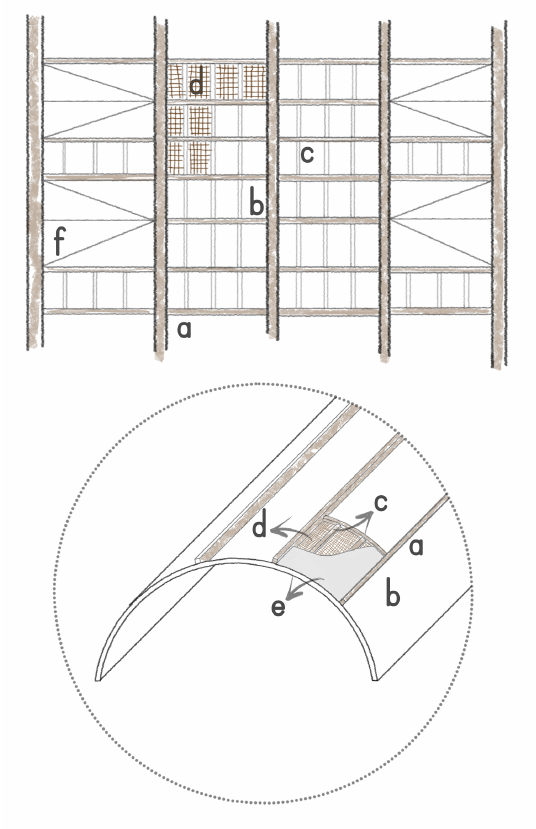
Figure 1. Explanatory sketch of the wooden vaults: plan and axonometry. Legend: a: filagne; b: jattole; c: contrasti; d: stuoiato (reeds); e: lime&gypsum coat; f: lunettes (Romano). Despite some critical issues, it should be pointed out that the lightness of the construction system made it particularly suitable to be used on fragile and pre-existing buildings. Moreover, the presence of the gypsum coat on the intrados and extrados justified its greater resistance compared to the classic wooden vaults and served to protect the structure from